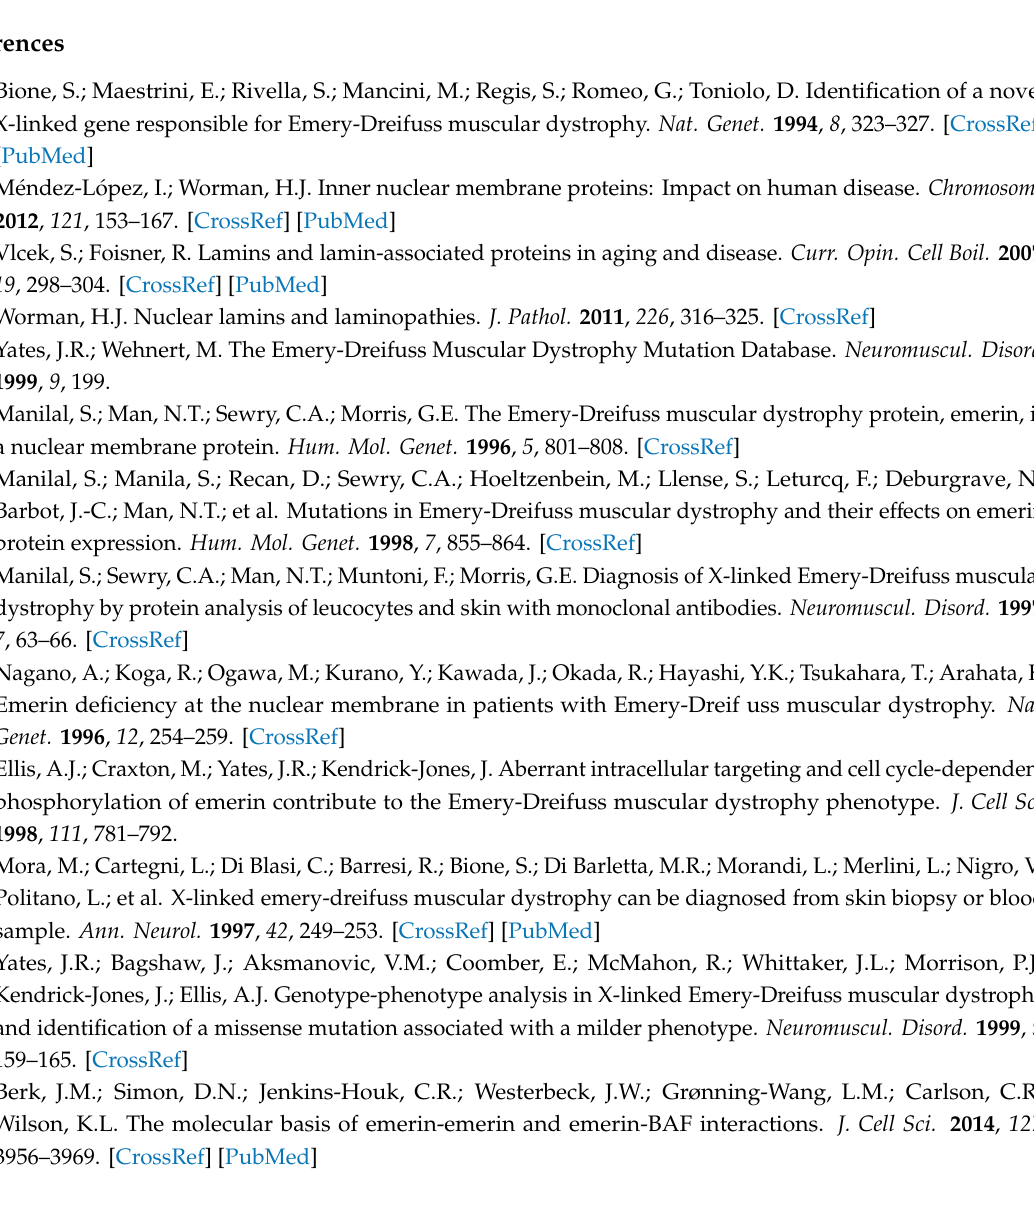
Figure S1: Cell cycle withdrawal 48 h after di ff erentiation induction of M179 and S54F mutant myogenic progenitors, Figure S2: Cell cycle withdrawal 72 hours after di ff erentiation induction of M179 and S54F myogenic progenitors, Figure S3: Cell cycle withdrawal 48 h after di ff erentiation induction of EDMD mutant progenitor lines Q133H and ∆ 95–99, Figure S4: Cell cycle withdrawal 72 h after di ff erentiation induction of EDMD mutant progenitor lines Q133H and ∆ 95–99, Figure S5: Significant changes in the transcriptome are seen during di ff erentiation of EDMD mutant myogenic progenitors, Figure S6: Significant changes in the transcriptome are seen at each daily transition during di ff erentiation of EDMD mutant myogenic